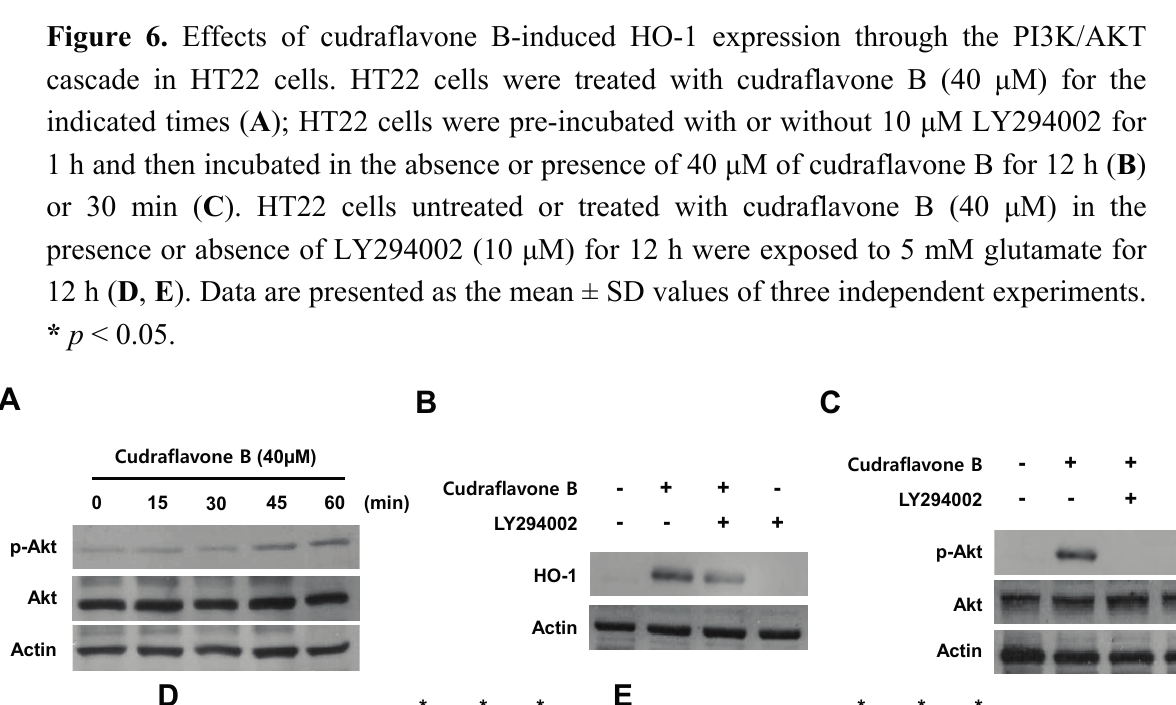
Figure 6. Effects of cudraflavone B-induced HO-1 expression through the PI3K/AKT cascade in HT22 cells. HT22 cells were treated with cudraflavone B (40 μ M) for the indicated times ( A ); HT22 cells were pre-incubated with or without 10 μ M LY294002